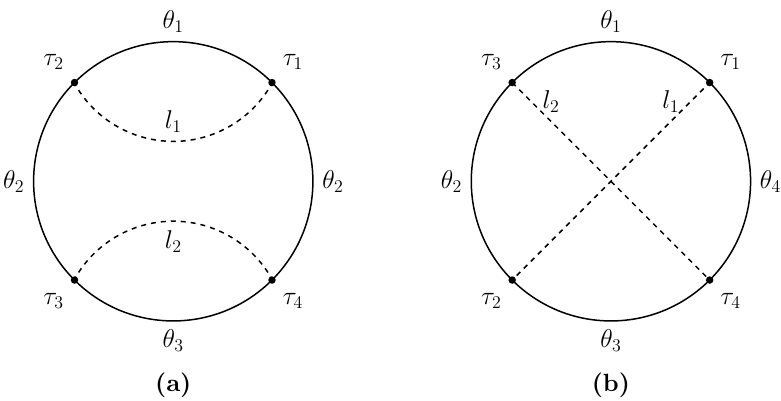
Figure 14. Skeleton chord diagrams of the 4-point functions h M 1 M 1 M 2 M 2 i and h M 1 M 2 M 1 M 2 i